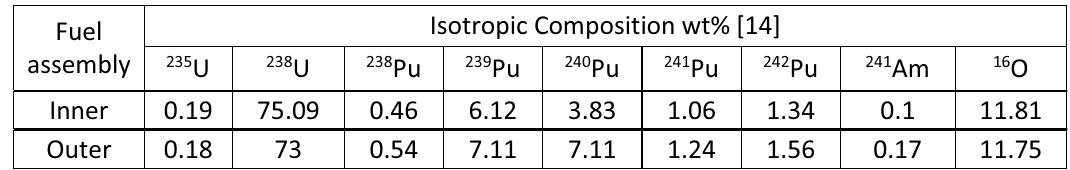
Figure 2. Horizontal and Vertical slice of MCNP Geometry for ESFR Core. Table I. Fuel Composition: Isotopic composition of fuel used in the ESFR inner and outer fuel